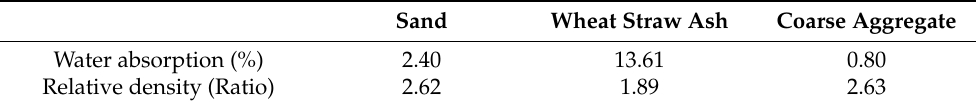
Figure 1. Gradation curves of sand and WSA along with ASTM C33 limits. Table 1. Relative density, water absorption of sand, WSA, and coarse aggregate. Sand Wheat Straw Ash Coarse